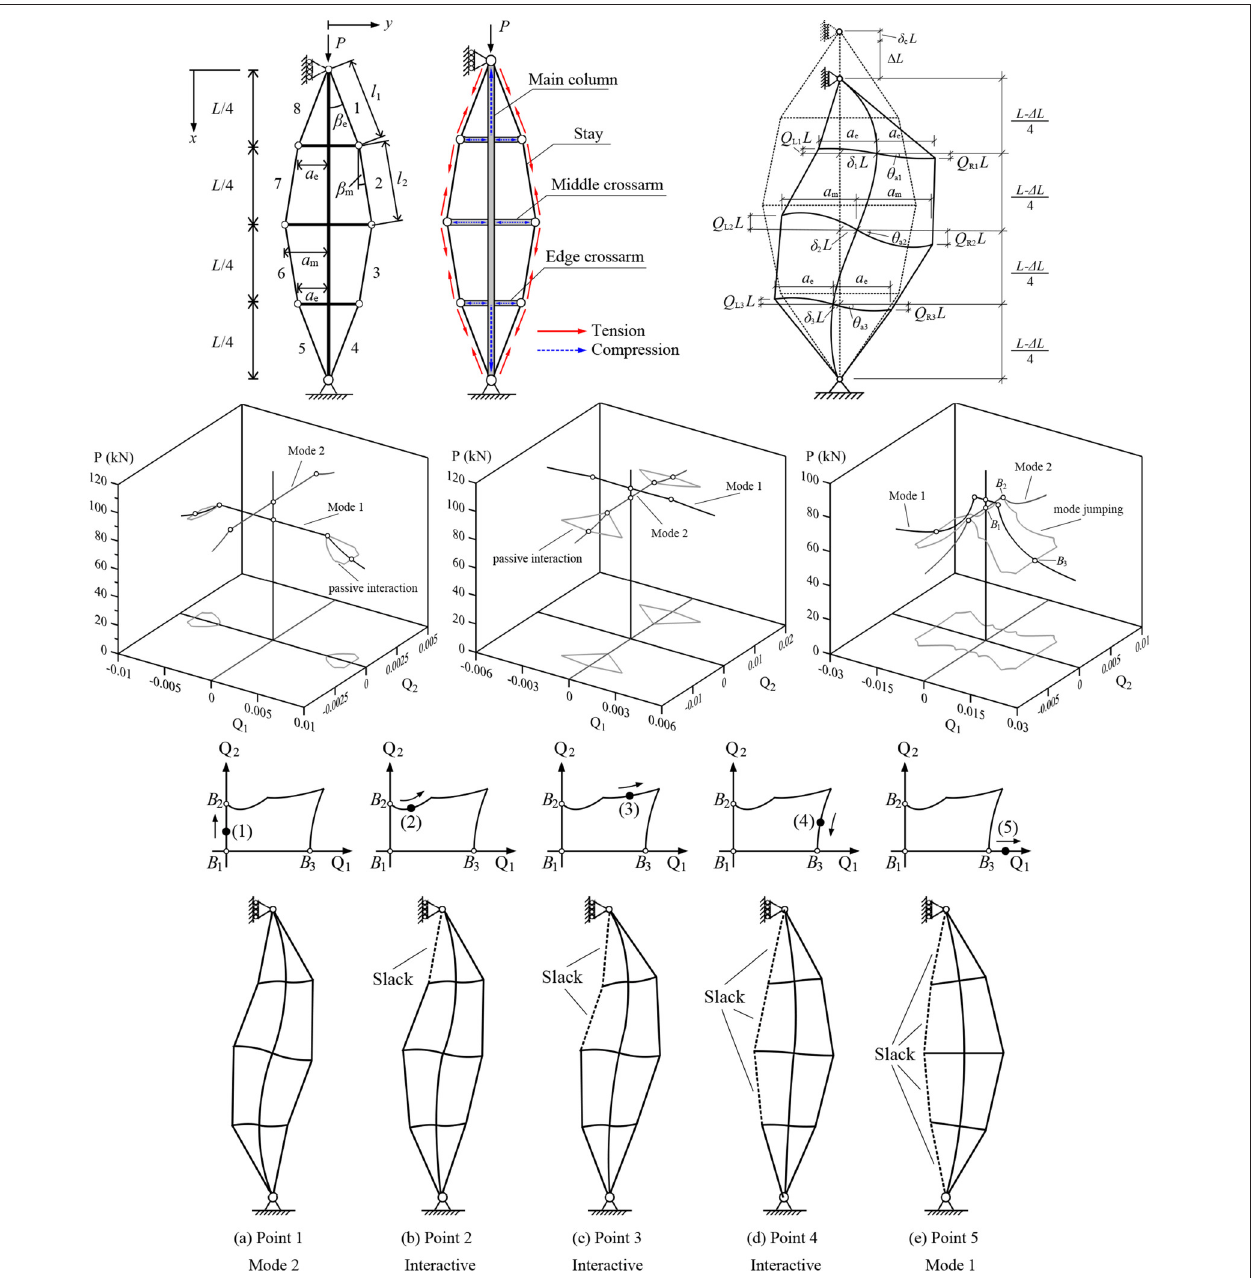
FIGURE 16 | Prestressed stayed column. (Row 1: left to right) Geometric definitions; effect of prestressing and buckled shape showing deformations of main column, cross-arms and stays used in the Rayleigh–Ritz model. (Row 2: left to right) Equilibrium paths showing: distinct mode 1 buckling ( Q 1 ); distinct mode 2 buckling ( Q 2 ); interactive buckling with a secondary mode jumping path. (Rows 3–4) Illustration of mode jumping through different points on the secondary mode jumping path from the third case in row 2 now plotted as Q 1 vs. Q 2 in row 3 and the deformed structure presented in row 4.